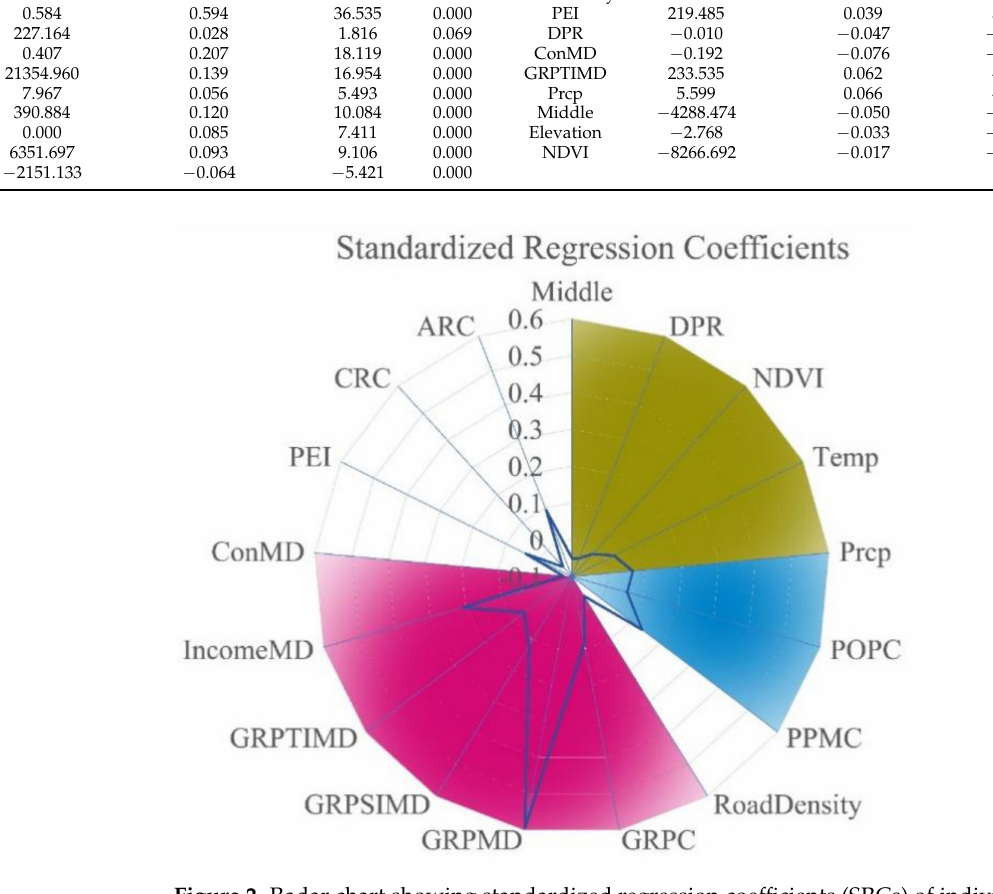
Figure 2. Radar chart showing standardized regression coefficients (SRCs) of individual indicators.